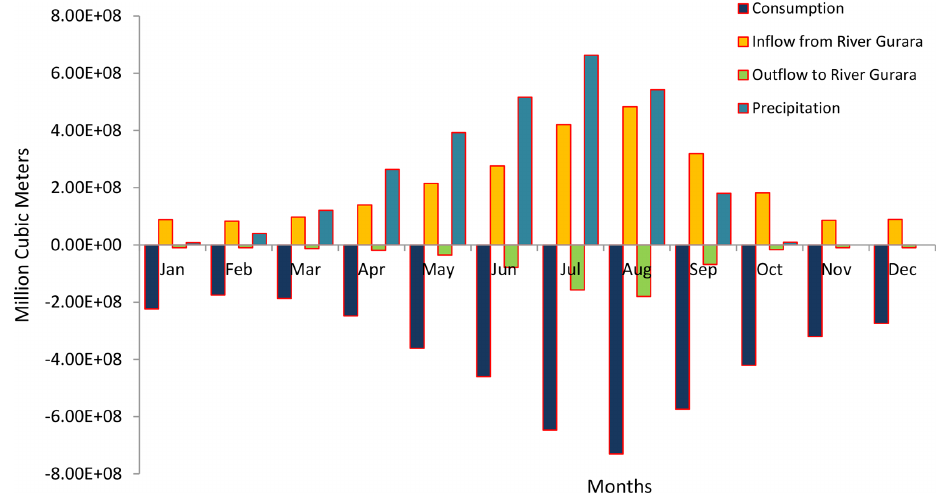
Figure 8. Water balance showing consumption, inflow, outflow and evaporation all scenarios with respect to baseline